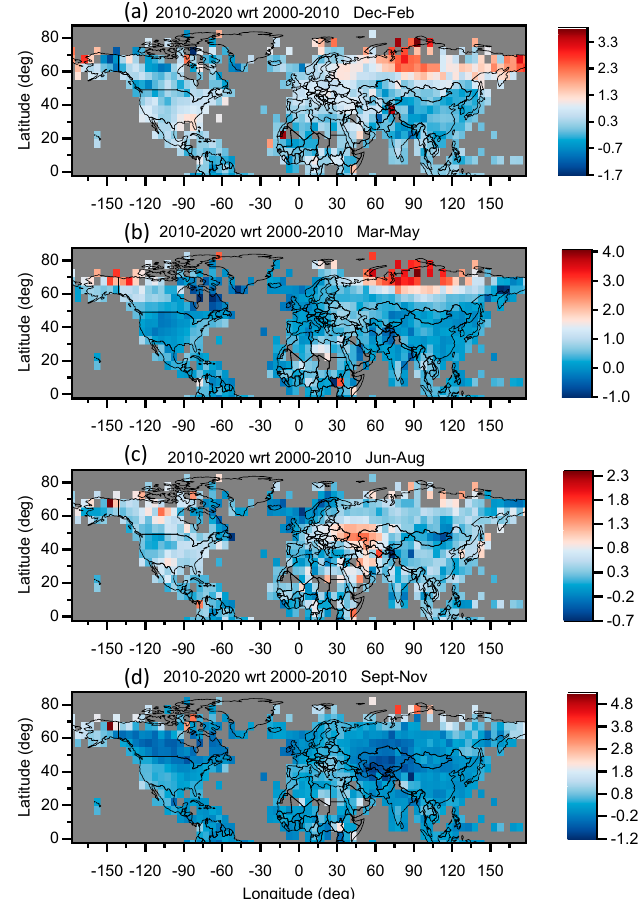
Figure 4. ( a – d ): Maps for seasonal NH land surface air temperature differences of 2010–2020 minus 2000–2010 in DJF, MAM, JJA and SON.